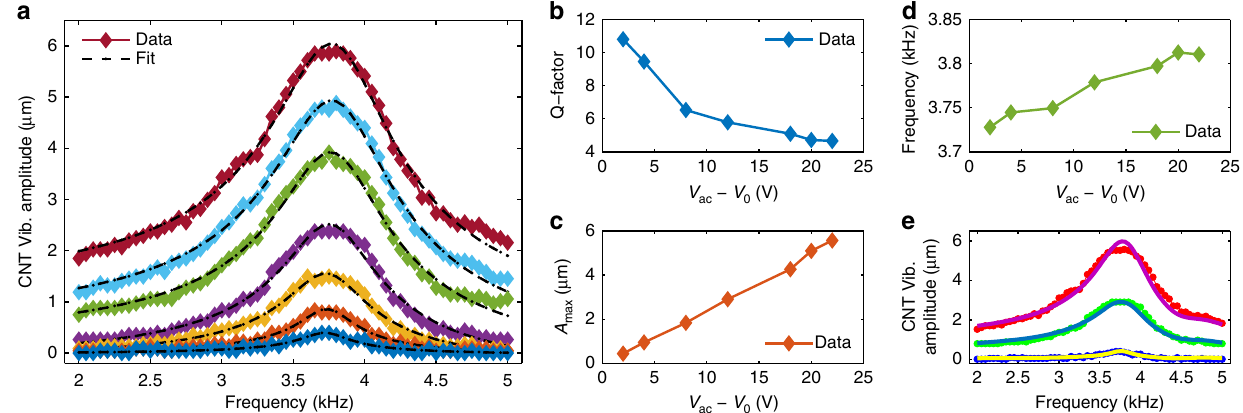
Figure 5 | Optically measured mechanical resonances of marked carbon nanotubes. ( a ) Amplitude of vibration of carbon nanotube (CNT) versus excitation frequency of a driven piezoelectric actuator, V ac . The different coloured curves are for different applied voltages of the piezo as plotted in c (2, 4, 8, 12, 18, 20 and 22V from bottom to top). The different black dashed lines are best fit to Lorentzian curves. ( b ) Quality factors as extracted from the Lorentzian fit. ( c ) Maximum amplitude versus the applied ac piezo voltages (subtracted offset bias originated from the electrical setup, V 0 ). ( d ) Frequencies of the maximal response for different excitation voltages. The chronological time of the measurements were from right to left. ( e ) The same data as in a for three different V ac ’s (dotted coloured lines) and resulted fit (colored lines) according to our finite element model (FEM) discussed in Supplementary Note 7. Vib., Vibration. NATURE COMMUNICATIONS|7:12153|DOI: